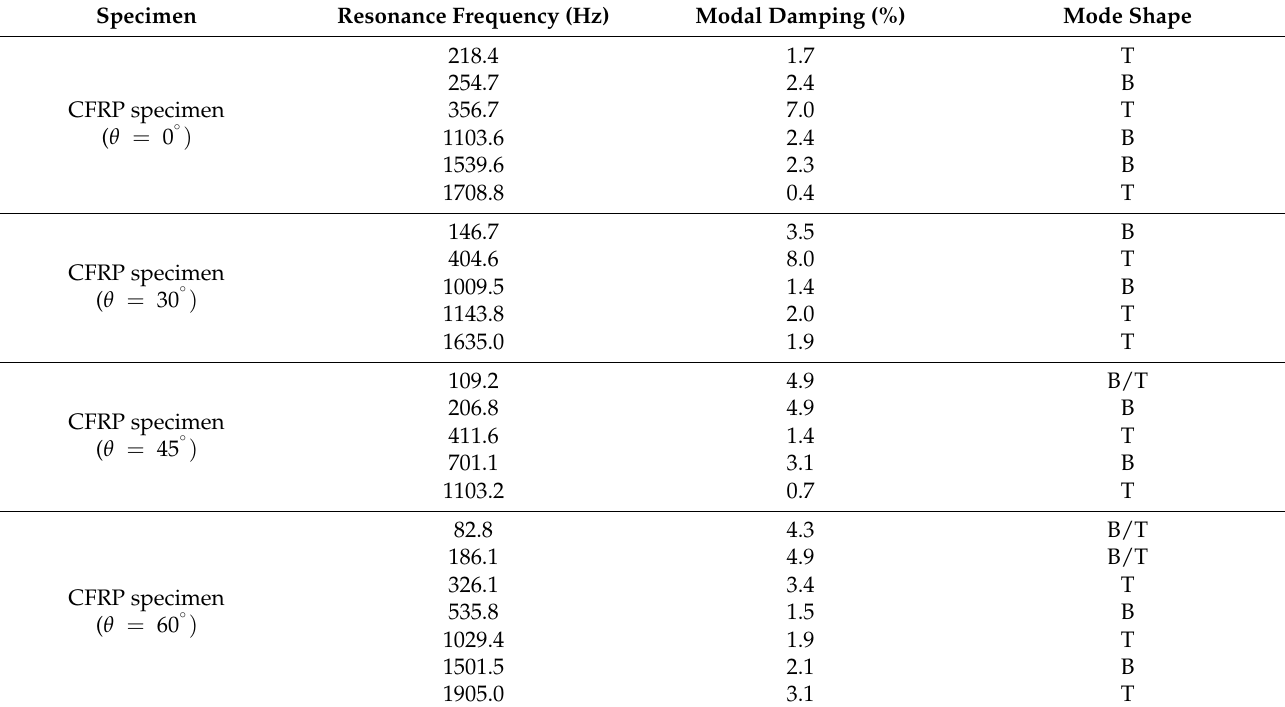
Figure 4. Configuration of simple specimens with attachment of accelerometers: ( a ) CFRP specimen with zero carbon fiber direction; ( b ) SCS13A specimen. Table 1. Summary of experimental modal analysis for all specimens.